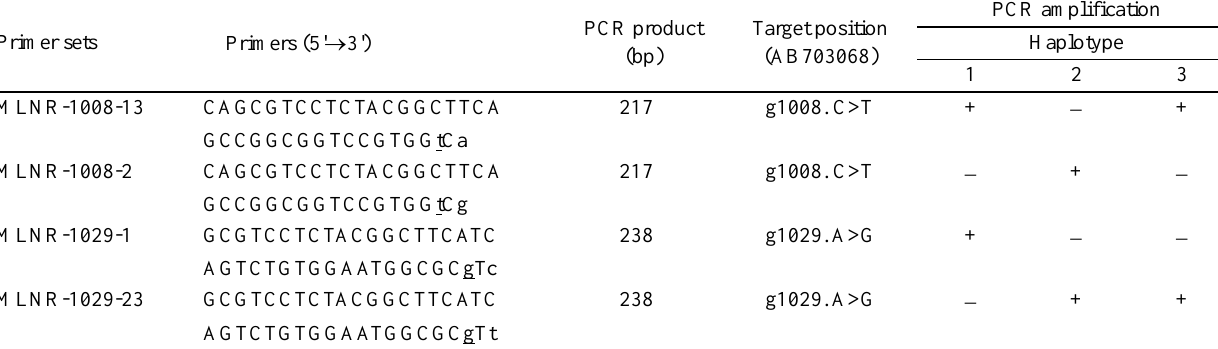
Table 3 Polymerase chain reaction (PCR) primers for the mismatch amplification mutation assay (MAMA) Primer sets